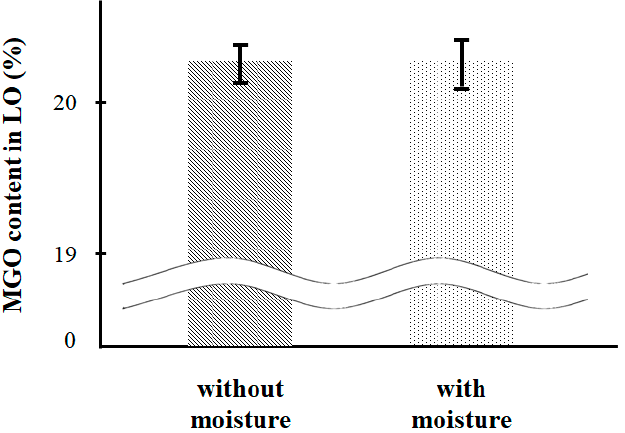
Figure 7. Comparison of marine gas oil (MGO) content in lubricating oil (LO) blends with and without moisture.